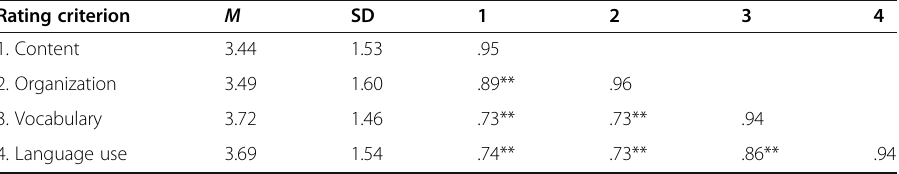
Table 8 Correlations for novice ratings (reverse) Rating